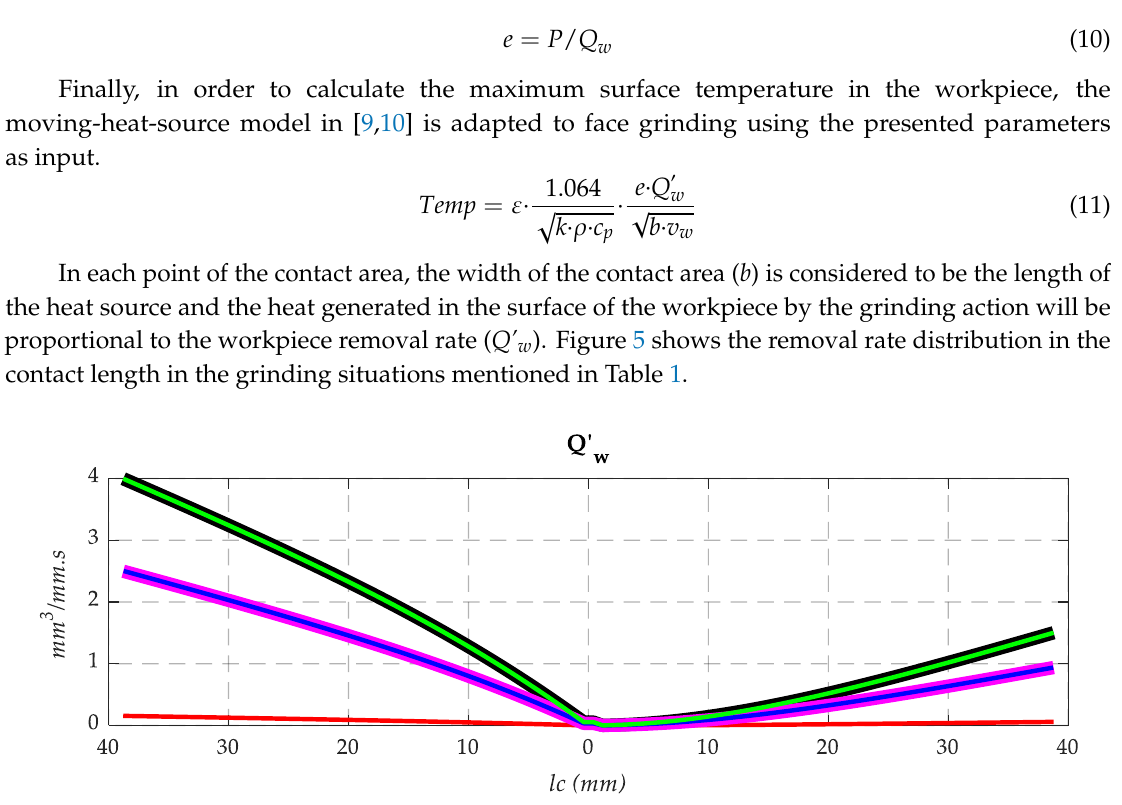
Figure 5. Material removal rate in the workpiece contact length ( Q’ w ).